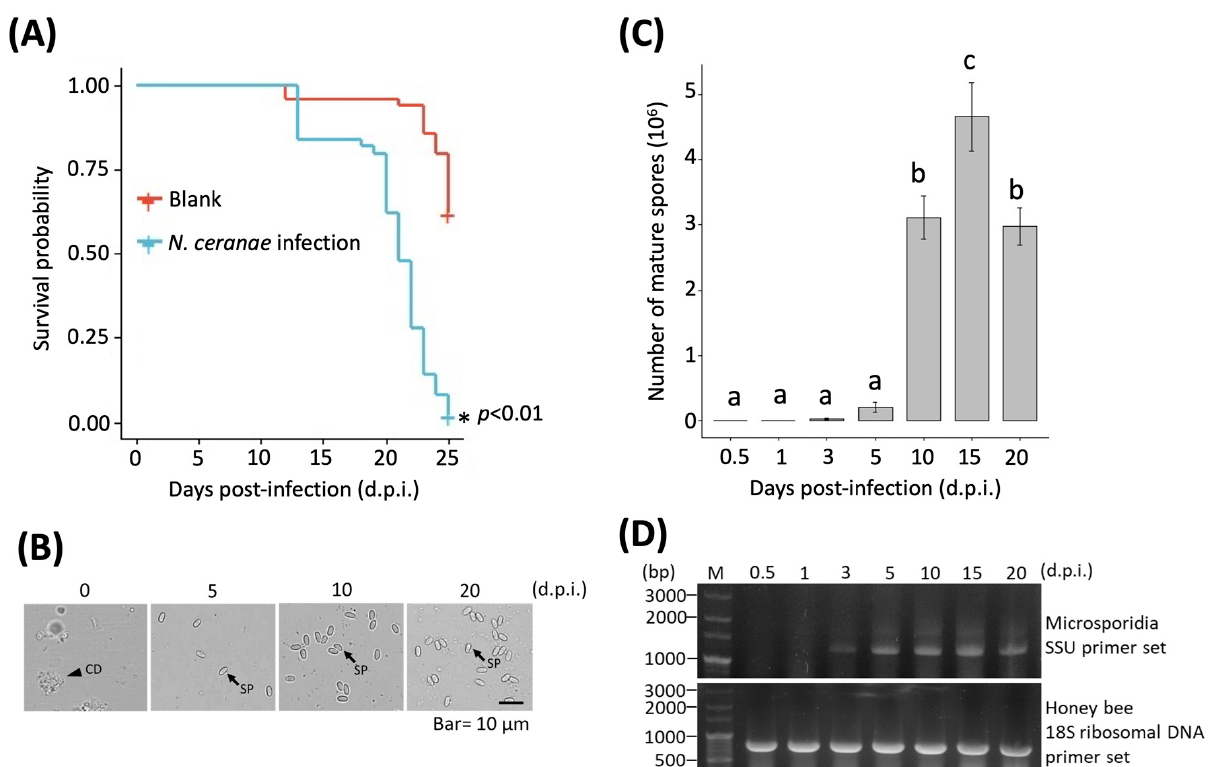
Figure 1. Observation and molecular identification of N. ceranae infection. ( A ) Kaplan–Meier survival curve (* = significant difference); ( B ) observation of mature spores; ( C ) mature spore counts (Different letters indicate significant differences ( p < 0.05)); and ( D ) molecular detection of N. ceranae infection at 0.5 (12 h), 1, 3, 5, 10, 15, and 20 d.p.i.; d.p.i. = days post-infection; CD = cell debris; SP = spore; the arrowhead indicates the cell debris; the arrow indicates the